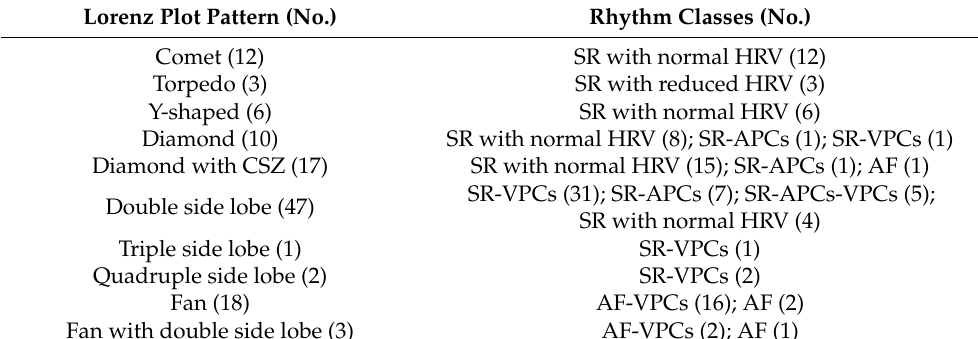
Table 4. Frequency of Lorenz plot patterns and related rhythm classes from Holter recordings used in this study. Lorenz Plot Pattern